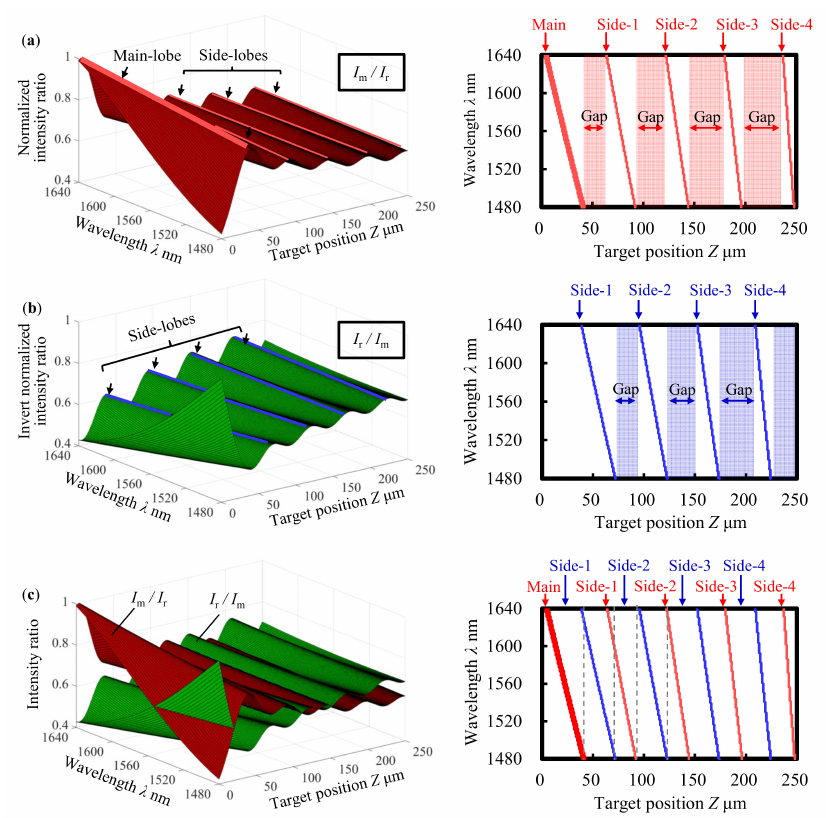
Figure 6. The main-lobe and the side-lobes in the axial responses obtained by the dual-detector chromatic confocal probe with a mode-locked femtosecond laser source. ( a ) Axial response of the normalized intensity ratio with target positions ranging from 0 to 250 µ m and a defocus d of 110 µ m. ( b ) Axial response of the invert normalized intensity ratio. ( c ) The main-lobes and the side-lobes in the axial